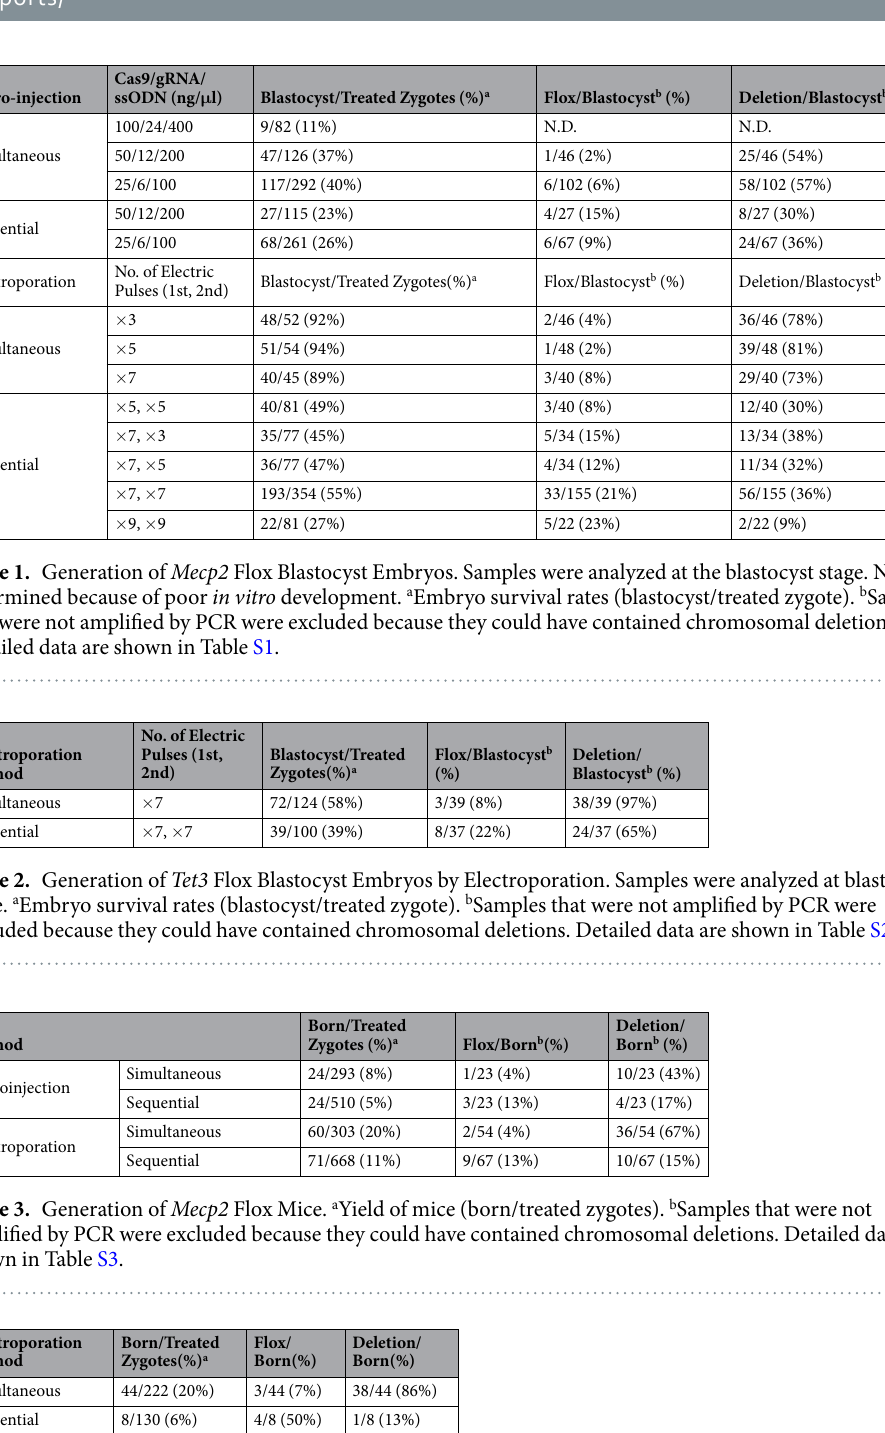
Table 4. Generation of Tet3 Flox Mice by Electroporation. a Yield of mice (born/treated zygotes). Detailed data are shown in Table S4.